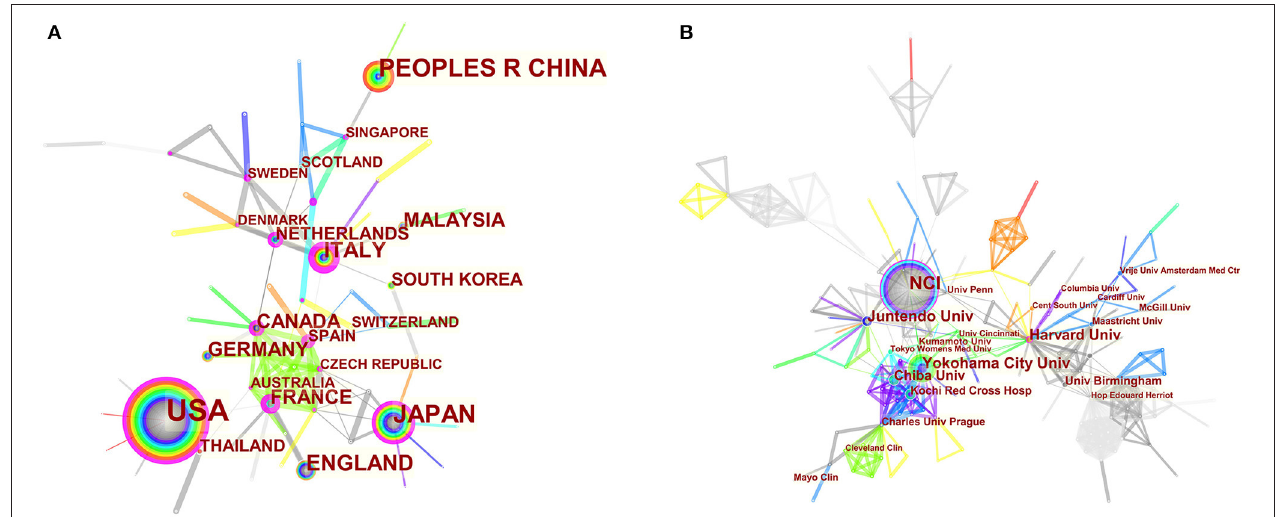
FIGURE 2 | (A) CiteSpace network map of countries/regions involved in BHD. (B) CiteSpace network map of organizations involved in BHD. Notes: Each circle represents a country/region or organization; the size of the circle is proportional to the publication outputs. The lines between the circles represent the collaboration between countries/regions or organizations; the thicker the lines, the closer the collaboration. The color of a ring denotes a time of publication. The gray ring in the inner circle represents the earliest publications from 2001, and the red ring in the outer circle is the most recent publications. The thickness of a ring is proportional to the number of publications in a given time slice. Purple outer rings indicate a high degree of centrality. Timespan: 2001-2021; Slice length = 1.